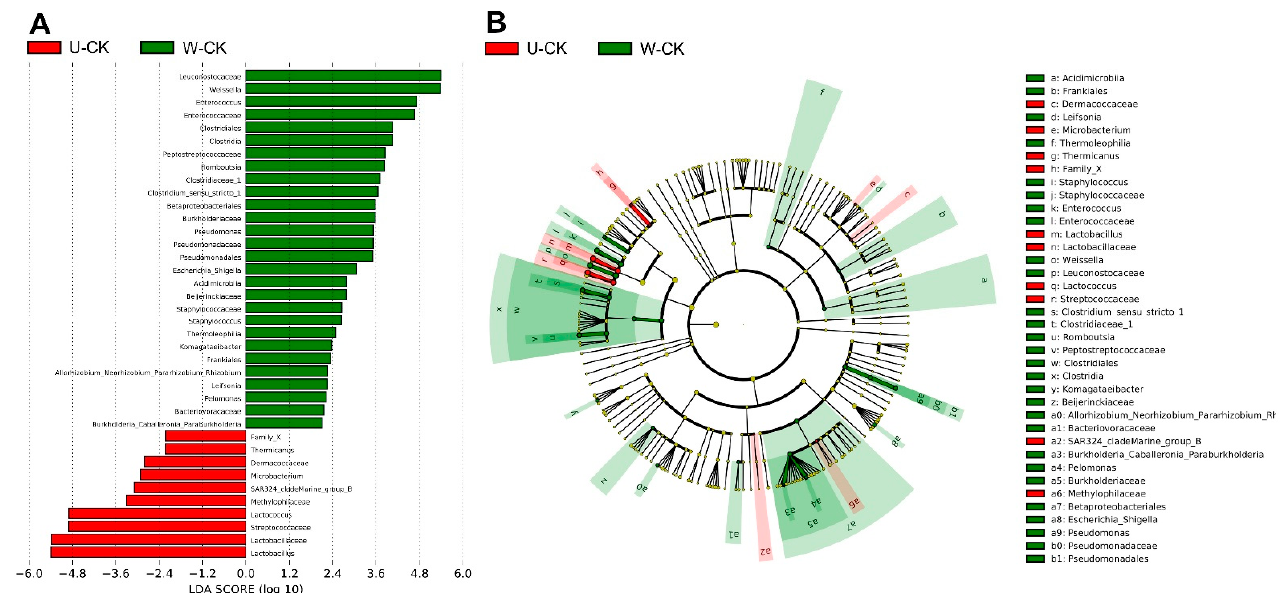
Figure 4. Comparison of microbial variations between U-CK and W-CK, using the LEfSe online tool. ( A ) Histogram of the LDA scores for differentially abundant features between U-CK and W-CK. U, wilt 0 h; W, wilt 3.5 h; and CK, control (no additives). The threshold on the logarithmic LDA score for discriminative features was set to 2.0. ( B ) Cladogram for taxonomic representation of significant differences. Differences are represented in the color of the most abundant taxa.